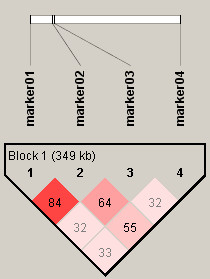
shows the linkage disequilibrium plot (obtained using Haploview) showing pairwise D' values (in percentage) between the four polymorphisms on chromosome 2q13. The markers 1, 2, 3 and 4 are IL1A +4845G>T, IL1B +3954C>T, IL1B -511 C>T and IL1RN +2018T>C respectively.